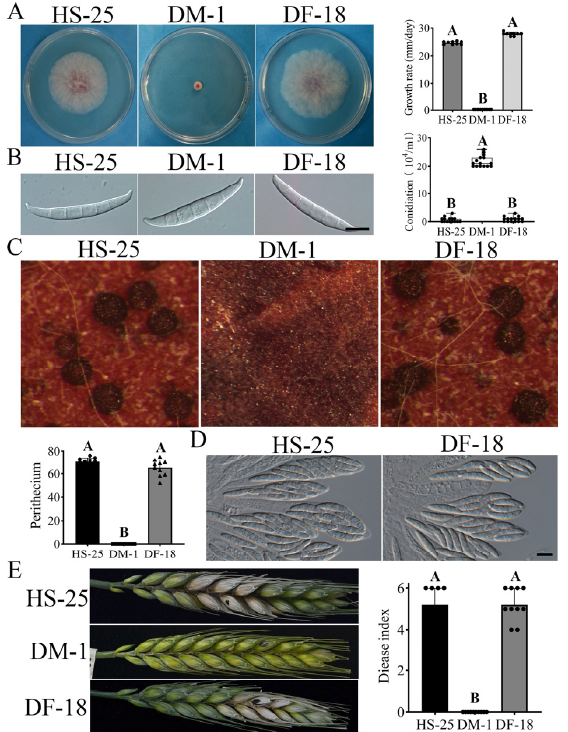
Figure 4. Verification of the suppressor mutations in FgSFL1. ( A ) Three-day-old PDA cultures of the wild-type strains PH-1, DM-1, and DF-18. ( B ) Conidiation of the wild-type strain PH-1, DM-1, and DF-18 after cultivation in CMC for five days. Bar = 20 µm. ( C ) Carrot agar cultures of PH-1, DM-1, and DF-18 were examined 7 days post-fertilization (dpf) and assay of perithecia of the wild-type strain PH-1, DM-1, and DF-18. ( D ) Ascospores of the wild-type strains PH-1, DM-1, and DF-18 were examined by differential interference contrast (DIC). Bar = 10 µm. ( E ) Flowering wheat heads were drop-inoculated with conidia of the same set of strains and photographed 14 days post-inoculation (dpi). Black dots mark the inoculated spikelets. Different letters indicate significant differences based on ANOVA analysis followed by Duncan’s multiple range test ( p = 0.01) in A, B.